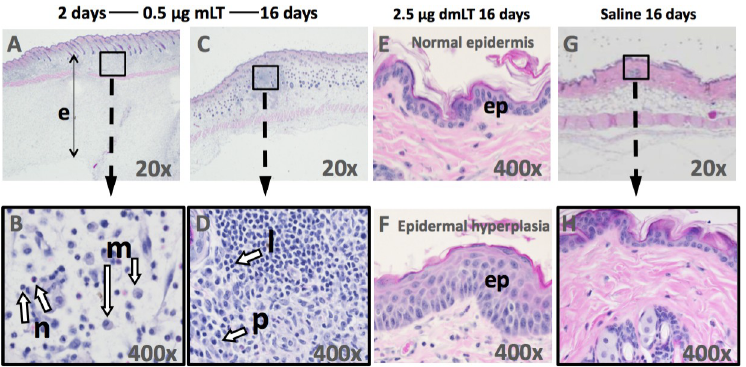
Fig 3. Hematoxylin and eosin-stained skin biopsy specimens obtained following ID injection with mLT or dmLT. Samples were taken sixteen days following the first immunization (S1; C, D, E, F, G, H) and two days following the second immunization (S2; A, B) from animals immunized with 0.5 μ g mLT ( A-D ) , 2.5 μ g dmLT ( E-F ) or saline ( G-H ) . Images were selected to represent the findings. The pathology of S2 (A and B) was characteristic of acute dermatitis while S1 (C and D) demonstrated chronic dermatitis. Magnification 20x (A, C, and G) and 400x (B, D, E, F, and H). e = edema; n = neutrophil; m = macrophage; p = plasma cell; l = lymphocyte; ep = epidermis.